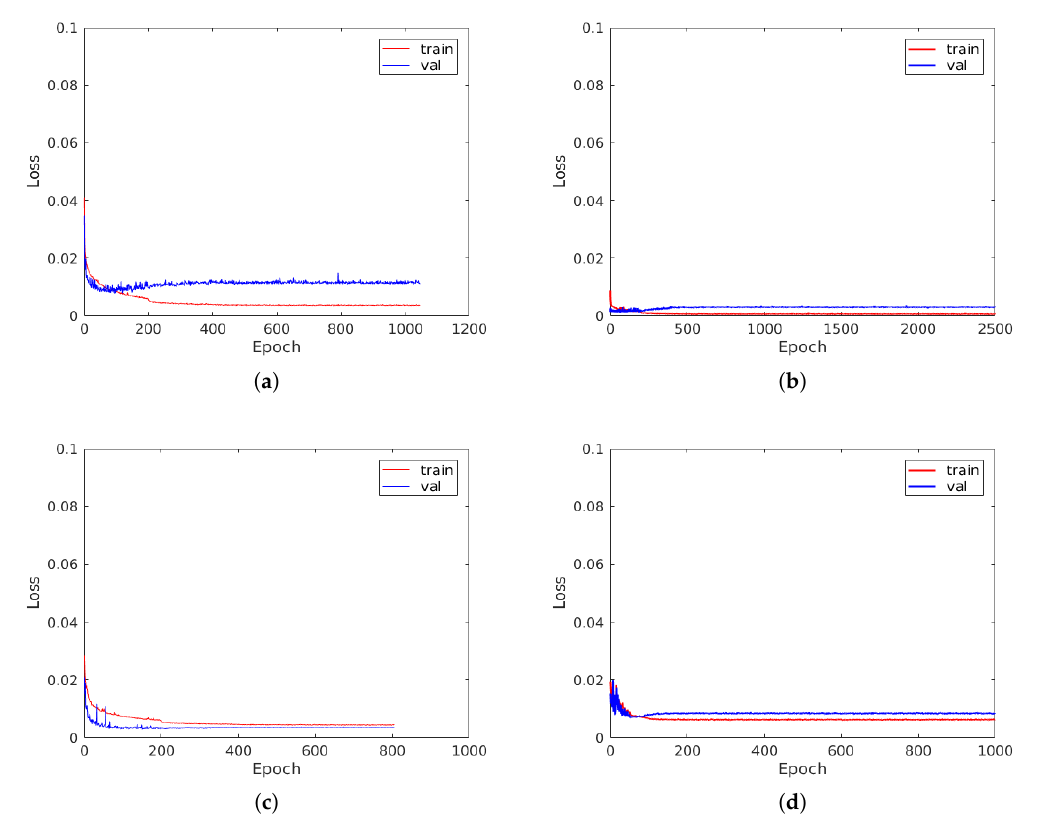
Figure 9. Evolution of the loss during training for supervised and unsupervised data in the spinach and bean fields. The validation loss curves decrease during about the first 80 epochs before increasing and converging. The top two figures represent the spinach field, and the bottom two correspond to the bean field. Figures on the left are from training on the supervised data, and those on the right are from training on the unsupervised data.